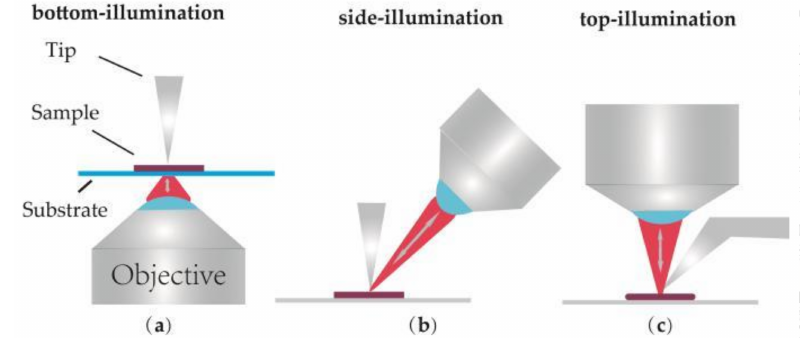
Figure 1. Illustration of commonly used illumination and detection geometries for Tip-enhanced